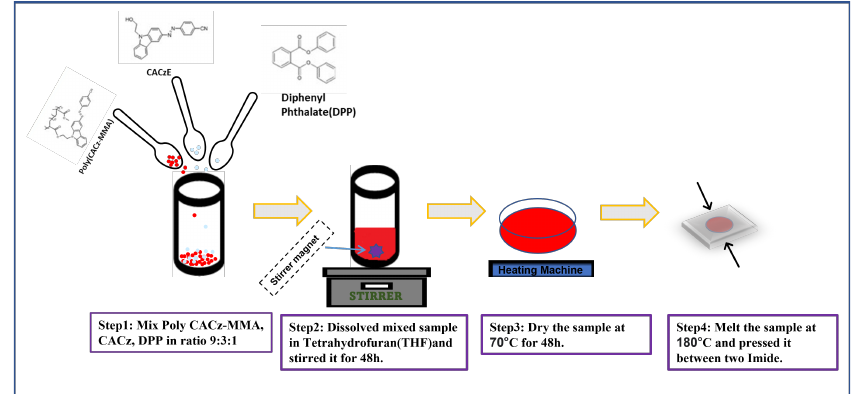
Figure 5. Process involved in the synthesis of azocarbazole polymer film.